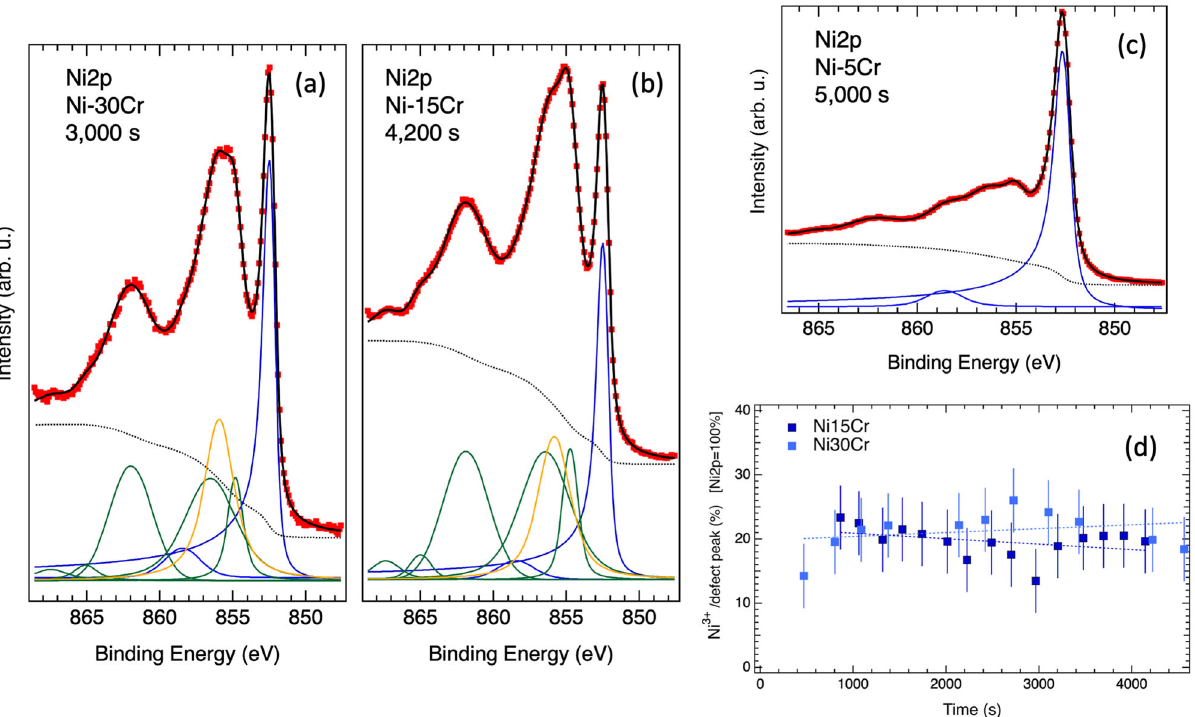
Fig. 3 Ni core level. Example of Ni2p 3/2 peak fi t for all binary alloys towards the end of the oxidation experiment: red line/symbols – experimental data, black line – fi t envelope, broken line – Shirley background – green lines: Ni(II) multiplet from NiO reference spectra, yellow line: assigned tentatively to Ni 3 + [alternative assignments are discussed in the text], blue line – Ni(0) in alloy. a Ni-30Cr, b Ni-15Cr, c Ni-5Cr. The oxide contribution to the Ni-5Cr peak is clearly visible but its intensity is insuf fi cient to fi t the oxide contributions; the fi t for the alloy peak is included in the graph. a , b include the fi t following the assignments established by Payne et al. ( d ) summarizes the Ni 3 + contributions for Ni-15Cr and Ni-30Cr as a function of oxidation time. The error bar in Fig. 3(d) in the contribution of the Ni 3 + /defect peak to Ni2p core level is ±5%. The error bar on the time axis is smaller than the size of the